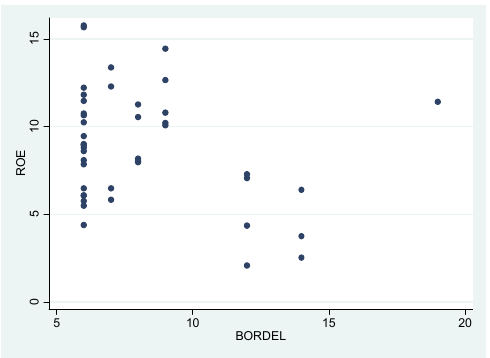
Fig. 3. The Pearson correlation between board diligence and return on equities in Jordanian Banks